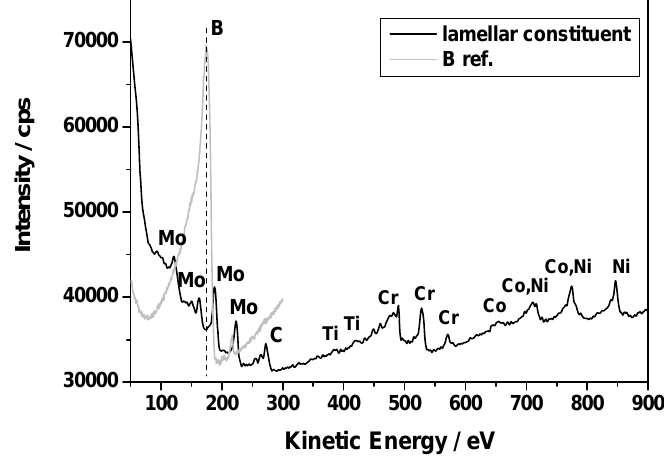
Figure 13. Local AES spectra for “bright phase” in lamellar constituent with reference boron peak.